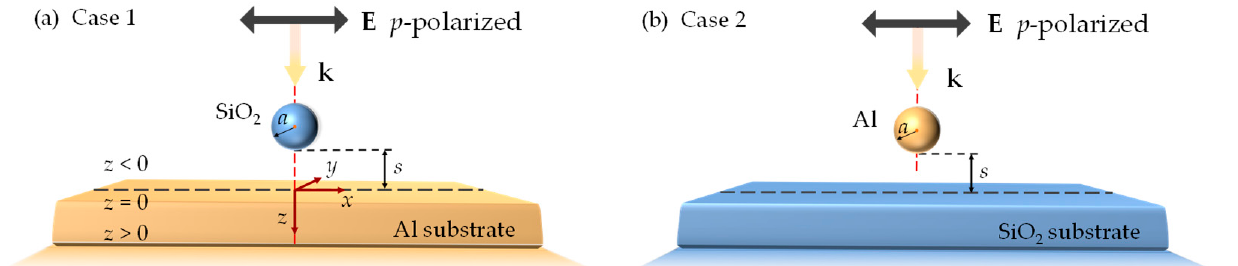
Figure 1. Schematic diagram of two geometric models studied in this paper. ( a ) Case 1: single SiO 2 spherical particle placed on the Al substrate; ( b ) case 2: single Al spherical particle located on the SiO 2 substrate. The coordinate system is shown, where z = 0 is set at the substrate surface. The radius of the sphere is a , while the gap size is represented by s . The p -polarized light is normally incident on the substrates with the incident wave vector k .